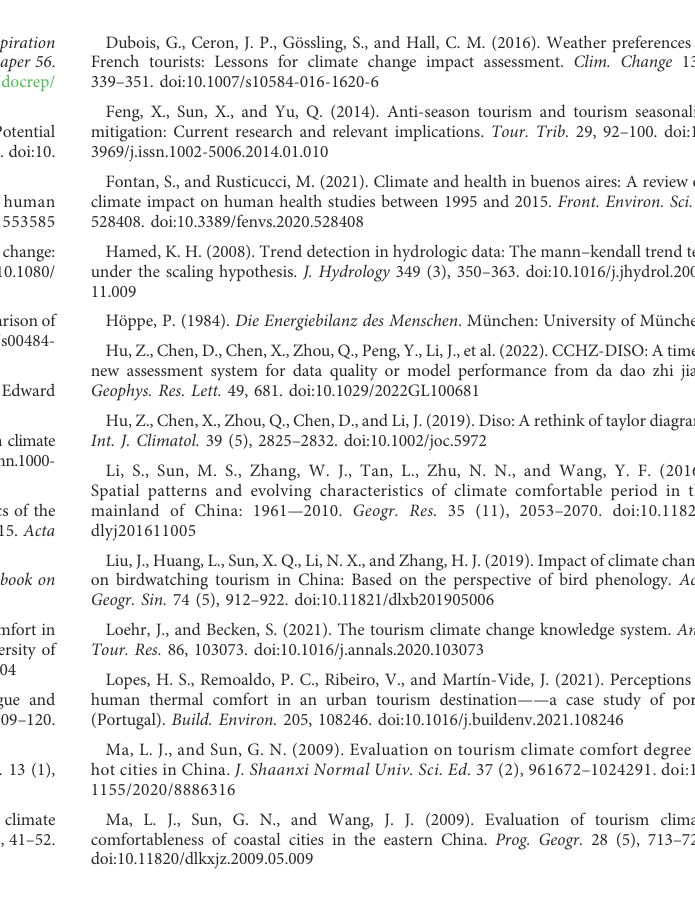
SUPPLEMENTARY FIGURE S1 1980 – 2019 monthly temperature trend of 31 cities over mainland